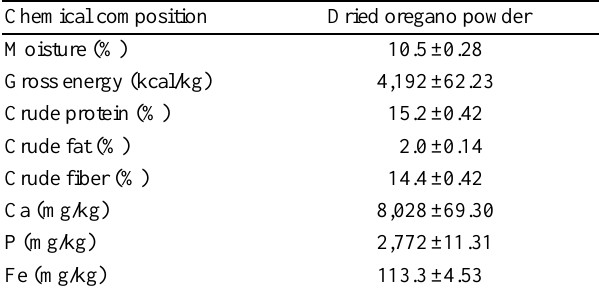
Table 2. Chemical composition of dried oregano powder Chemical